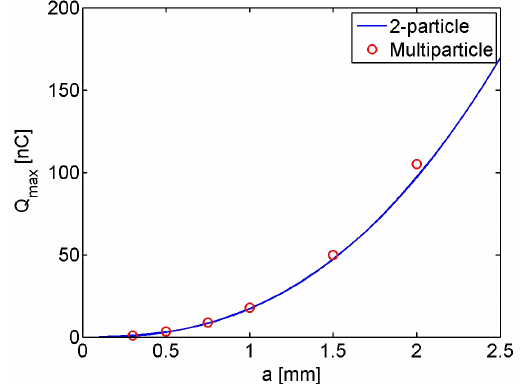
FIG. 6. Maximum acceleration gradient as a function of the radius in the DWA linac for η ¼ 80 %. The blue line is the maximum gradient and the grey area underneath is the region of permissible gradients. [The dashed lines show the gradient scaling ( Q=a 2 ) when SBBU is ignored.] ffiffiffiffiffiffiffiffiffiffiffiffiffi p E max ½ MV = m (cid:3) ≈ 290 × a ½ mm (cid:3) : ð 12 Þ z